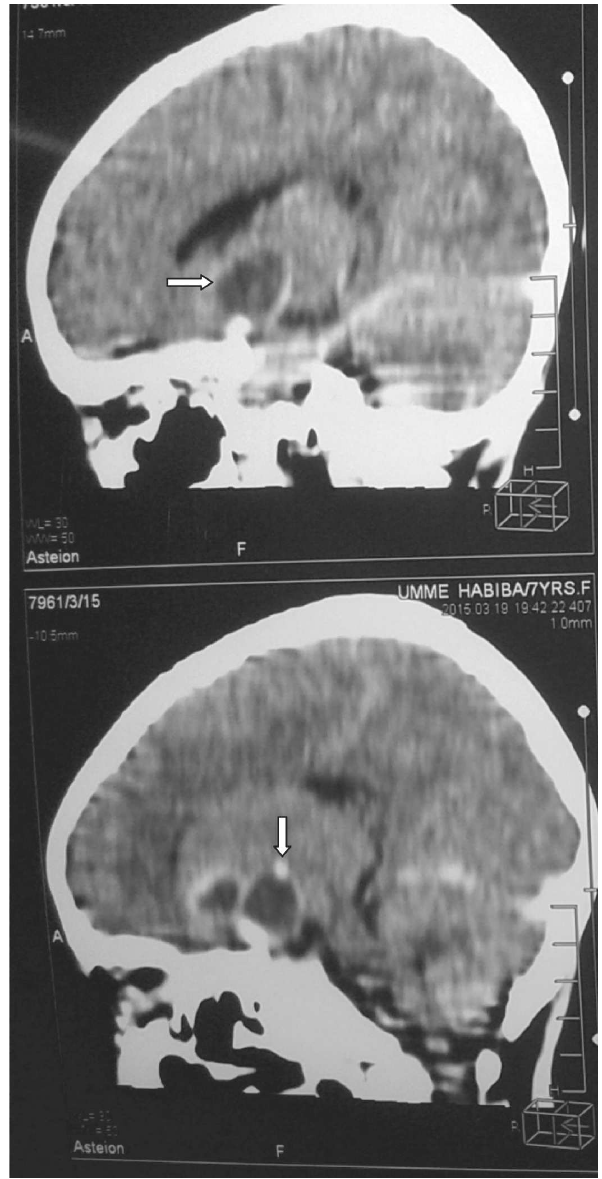
Fig 2. A loculated multicystic mass in the midline suprasellar region with heterogenous soft tissue nodules (sagittal